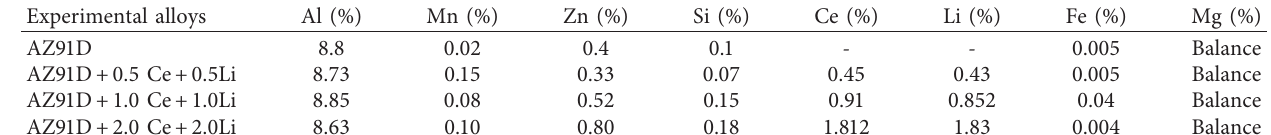
Table 1: Chemical composition of magnesium alloys used in this work.